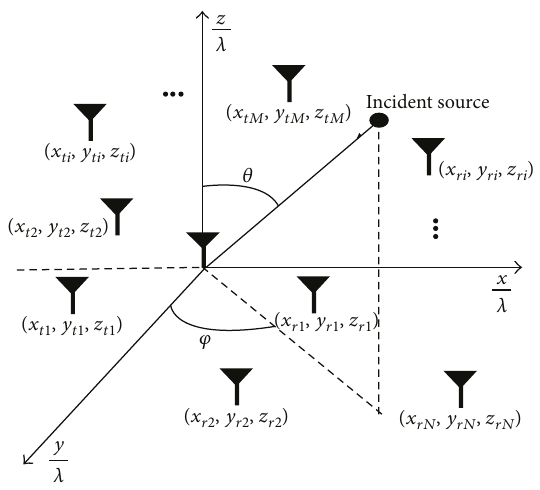
Figure 1: System model of 2D massive MIMO with an MxN arbitrary array con fi